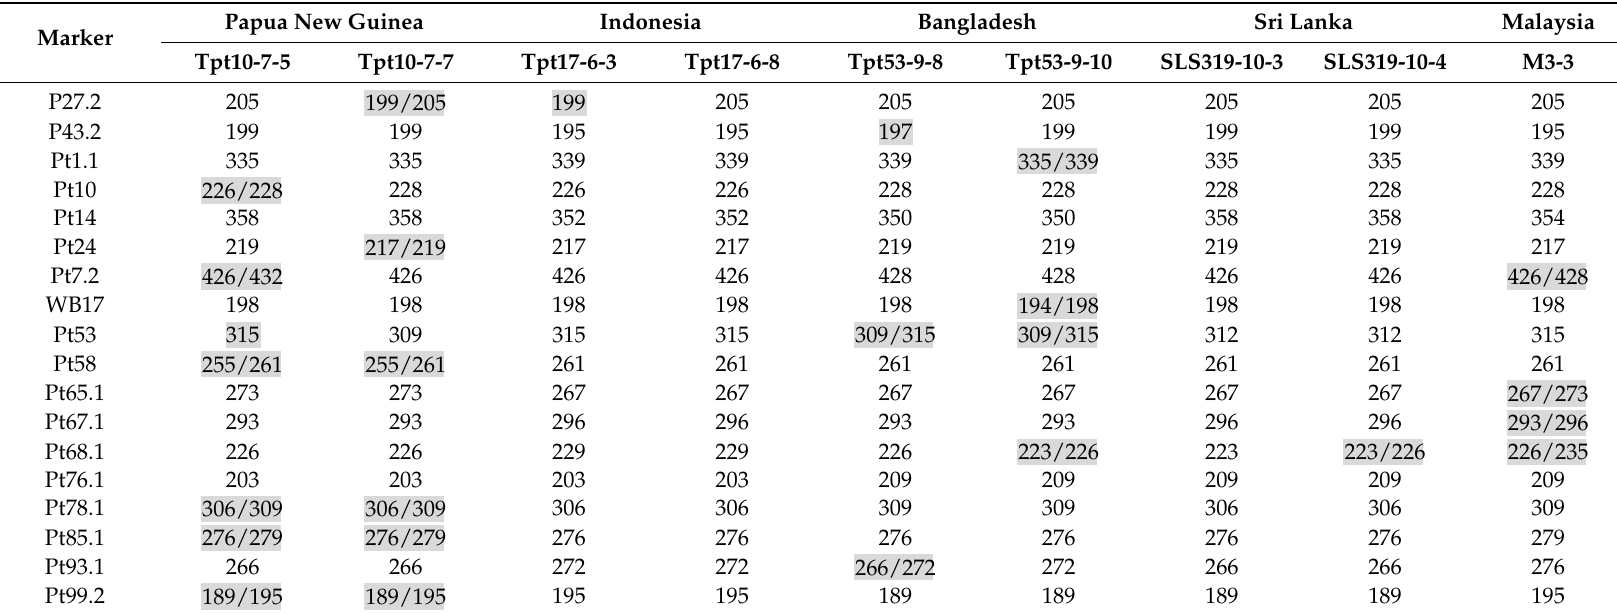
Table 5. Scores of 18 SSR markers from nine winged bean